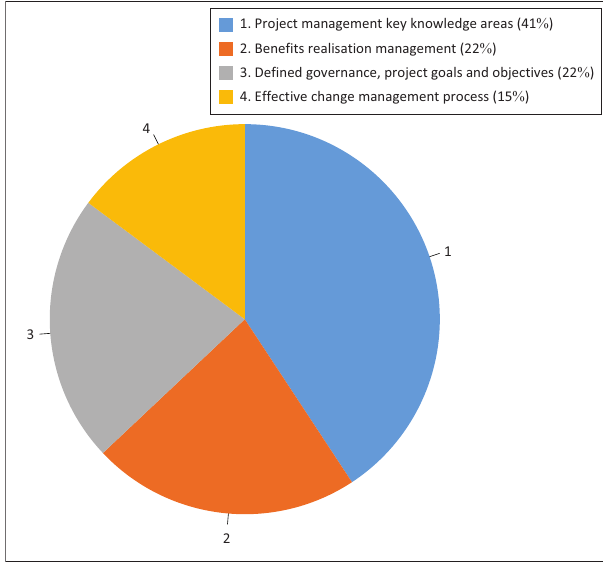
FIGURE 1: Factors contributing to project success.